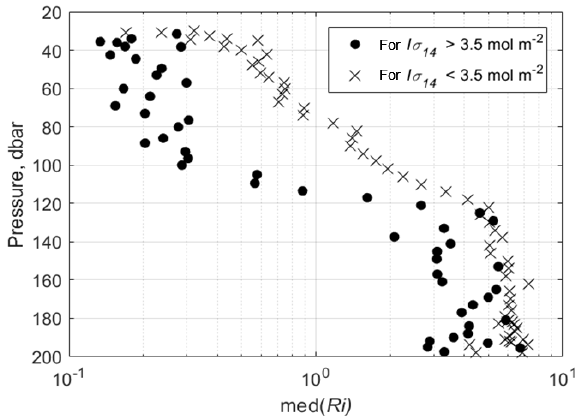
Figure 13. Vertical profiles of the median values of the Richard- son numbers, which are estimated based on two data ensembles: for I σ 14 < 3 . 5molm − 2 and I σ 14 ≥ 3 . 5molm − 2